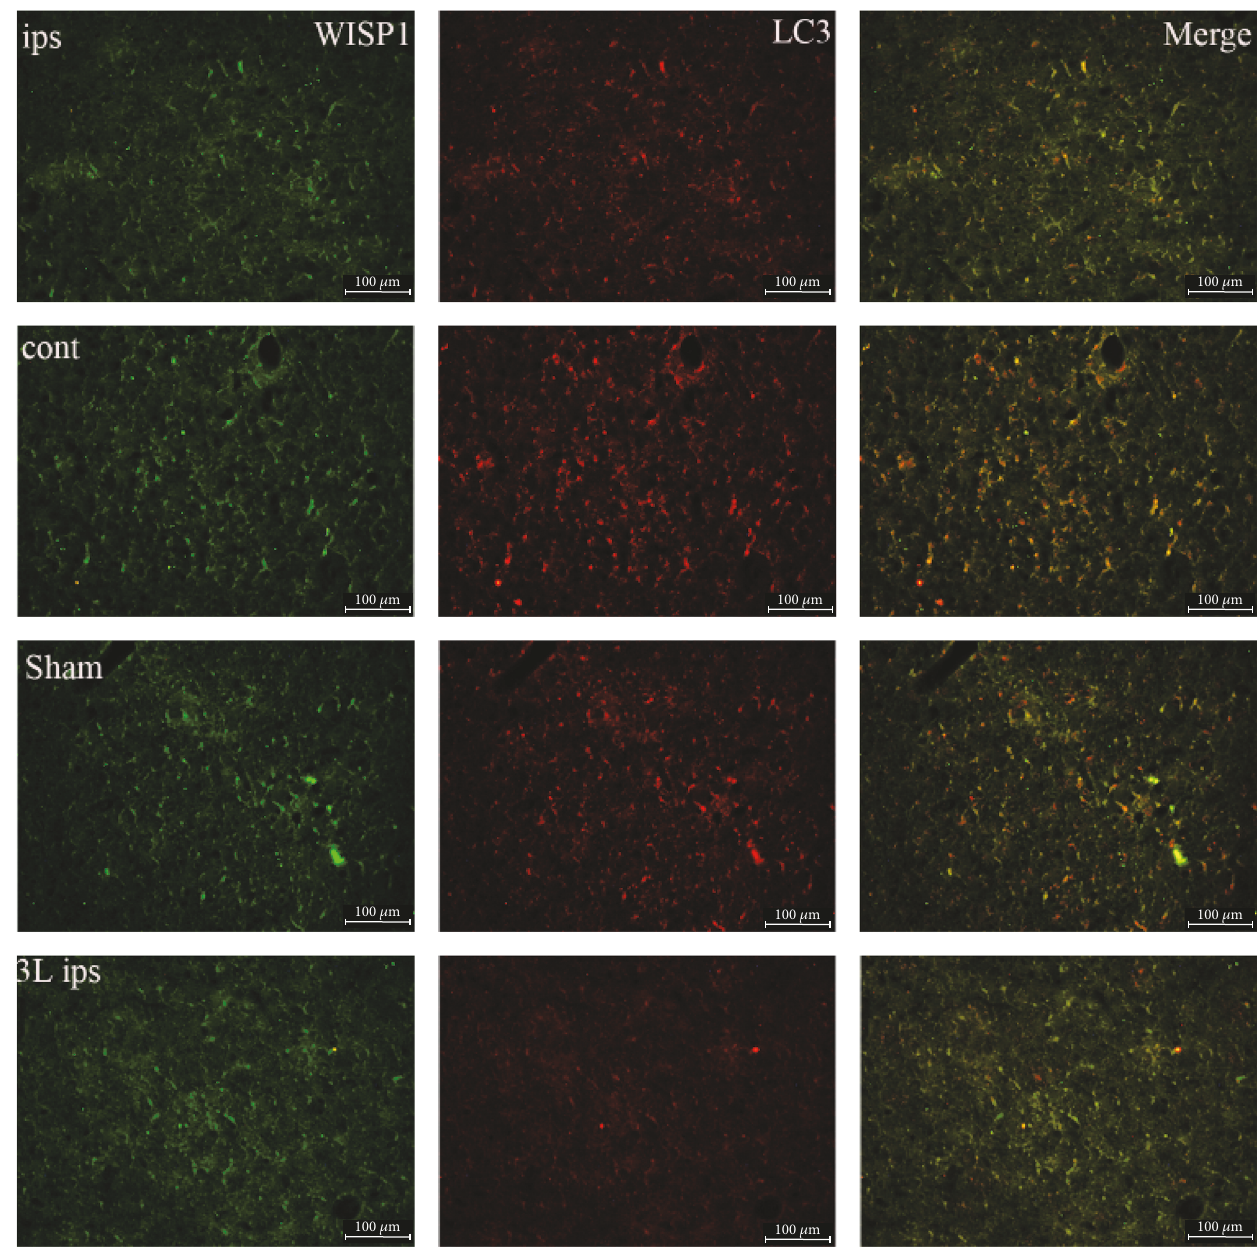
Figure 5: Double-labeling immuno fl uorescence of WISP1 and LC3 at 3d after TBI. Green: WISP1; red: LC3; cont: the control of ipsilateral 3d post-TBI group; ips: ipsilateral 3d post-TBI group; sham: sham group; 3L ips: 3 d post-TBI +1mM PQQ group; cont: the control of ipsilateral 3d post-TBI+1 mM PQQ group. Bar=100 μ